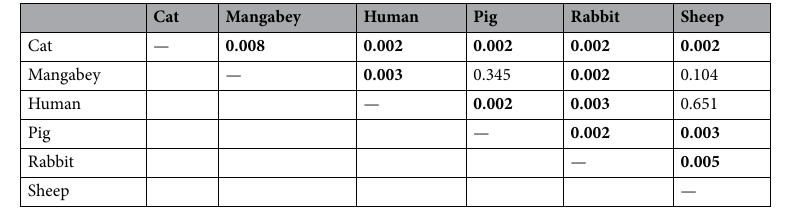
Table 1. The results of a non-parametric MANOVA to calculate statistical significance between the species within the RTT bone (p <